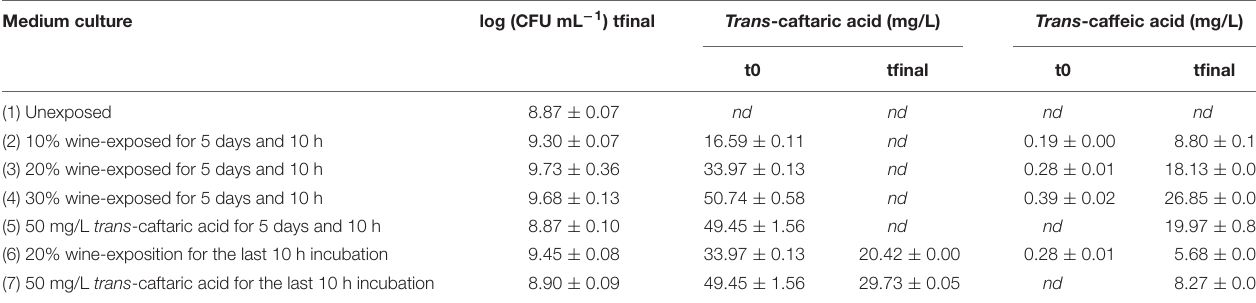
TABLE 5 | Trans -caftaric and trans -caffeic acids concentrations in different cultures of O. oeni OenosTM before (t0) and after (tfinal) 5 days and 10 h growth and a certain time of substrate-exposure (5 days and 10 h or only 10 h) at 25 ◦ C. Medium